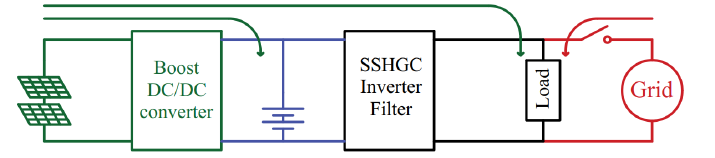
Figure 11. Power operation mode